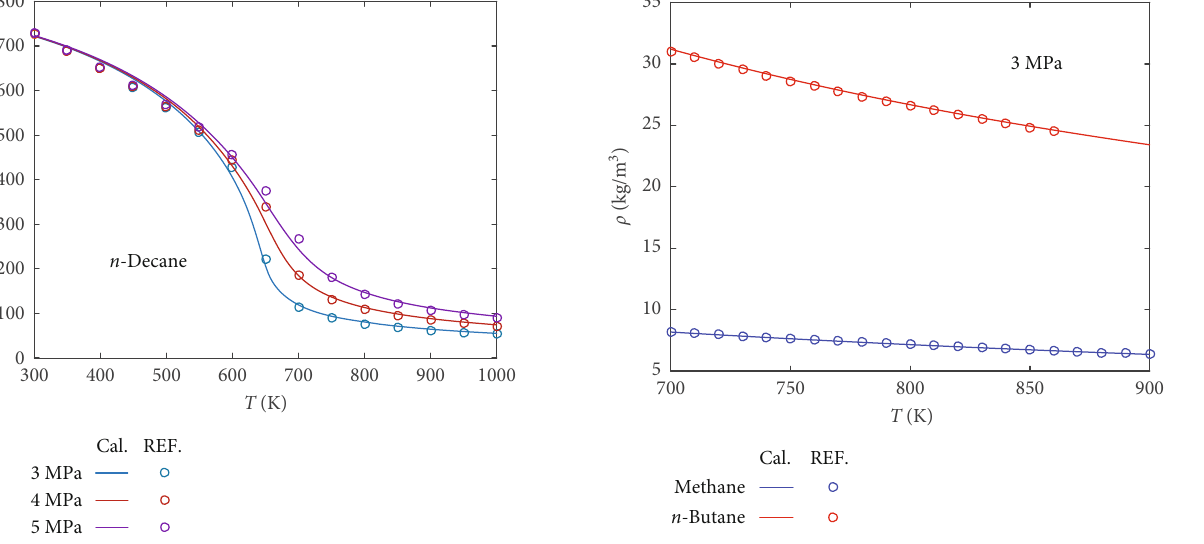
Figure 2: Comparison of densities of methane and n -butane under 3 MPa.